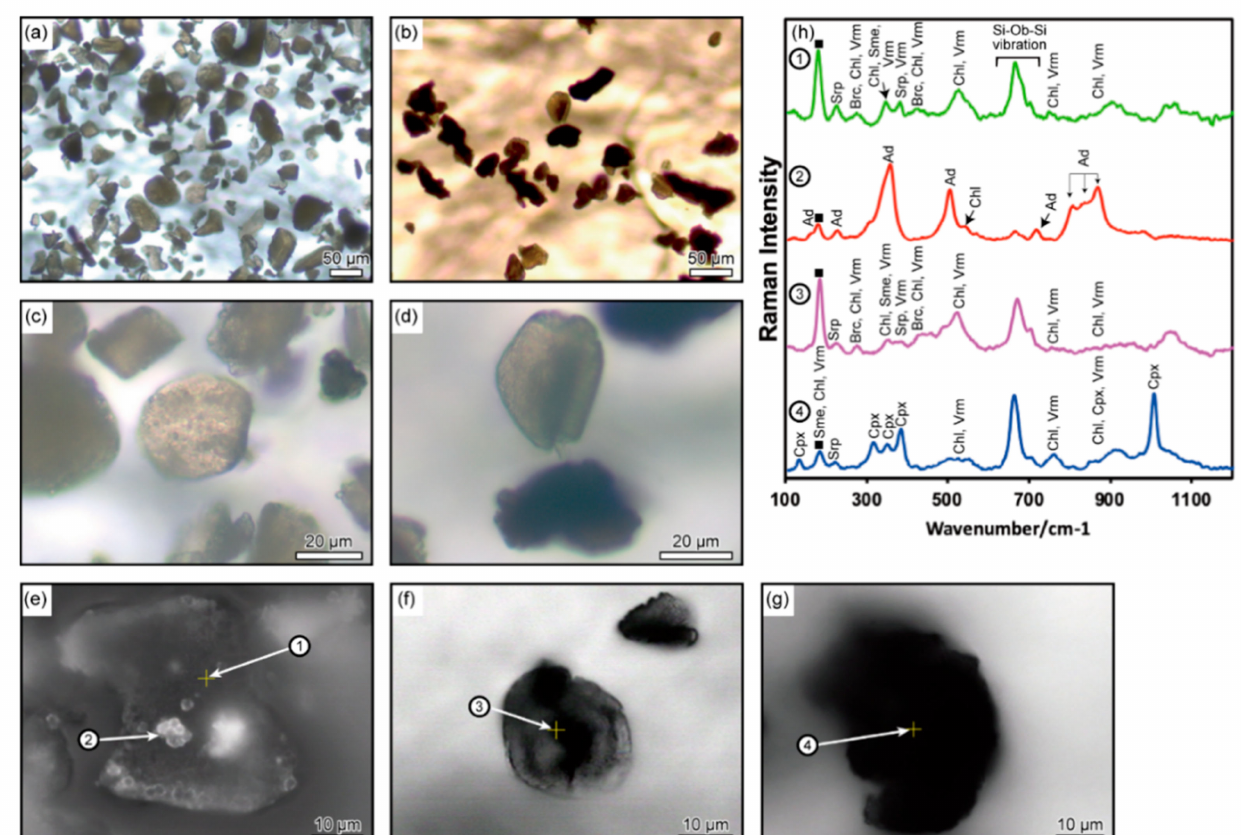
Figure 6. Optical microscopy images and Raman spectra of grains in unsuspended fractions separated from the bulk products at 250 ◦ C and 350 ◦ C. ( a , c , e ) Photomicrographs of an unsuspended fraction in experiments N250 (250 ◦ C, 4877 h) showing yellowish green grains (10–50 µ m in size). Small spherical grains (ca. 1 µ m in size) are often found on the surface of yellowish green grains. ( b , d , f , g ) Photomicrographs of an unsuspended fraction in experiment N350 (350 ◦ C, 2520 h) showing two types of grains: rounded greenish grains (20–50 µ m in size) and random-shaped opaque grains (20–50 µ m in size). Numbers in Figure 6e–g; correspond to those shown in Figure 6h. ( h ) Representative Raman spectra. Raman spectra of the yellowish green grains of N250 and the greenish grains of N350 (numbers 1 and 3) show peaks attributable to smectite, chlorite, actinolite, and serpentine that have nearly the same wavenumber. Raman spectra of the small spherical grains of N250 (number 2) show peaks attributable to andradite. Raman spectra of the random-shaped opaque grains of N350 (number 4) show the peaks attributable to clinopyroxene. A large peak between 650 cm –1 and 700 cm –1 is common in inosilicate and phyllosilicate candidates. Abbreviations in Figure 6h are the same as in Table